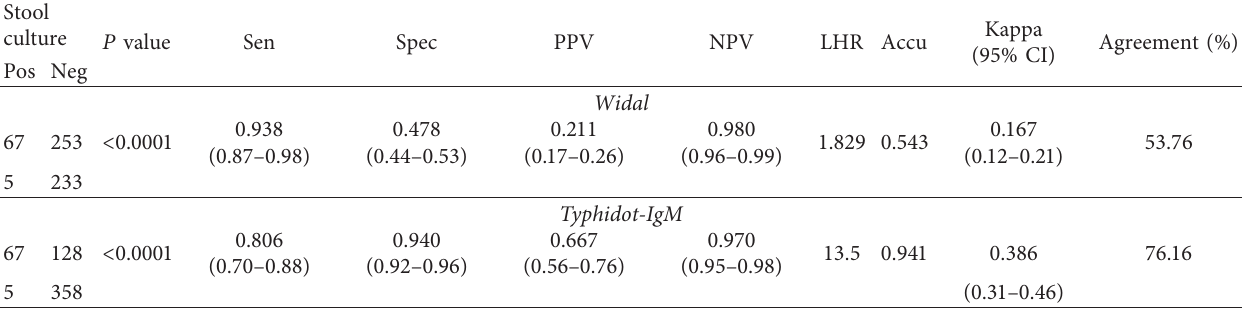
Table 4: Performance of the Widal test and Typhidot immunoassay against the reference standard for the diagnosis of typhoid fever. Stool culture